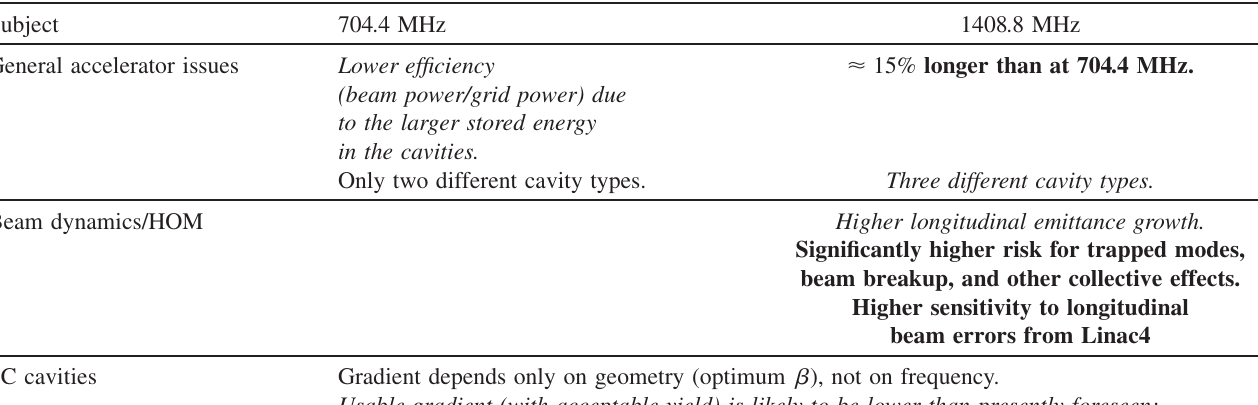
TABLE XX. Summary of statements concerning the frequency choice (disadvantages in italic , advantages in upright font, decisive criteria in